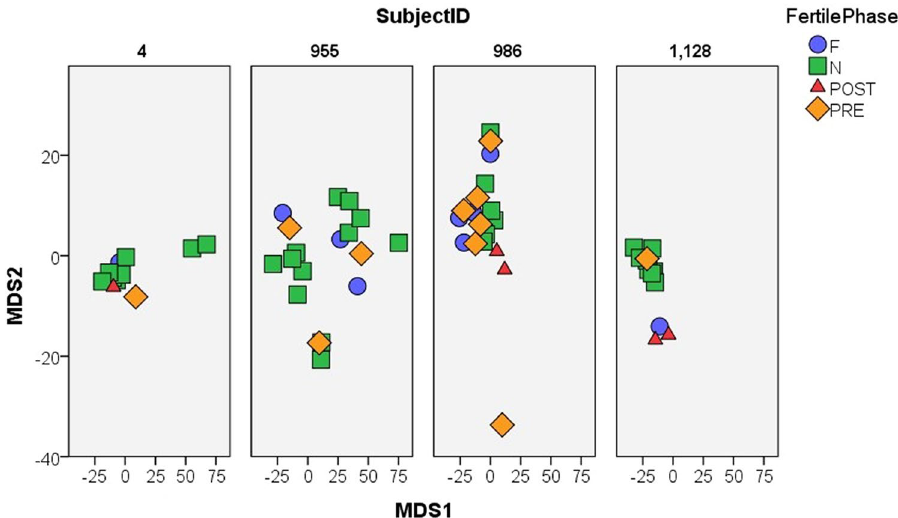
Figure 6. Scatterplot showing that MDS1 and MDS2 calculated from the percentage data do not separate the different cycle stages into clusters. F, N, Post, and Pre are fertile, non-fertile, post-fertile, and pre-fertile,